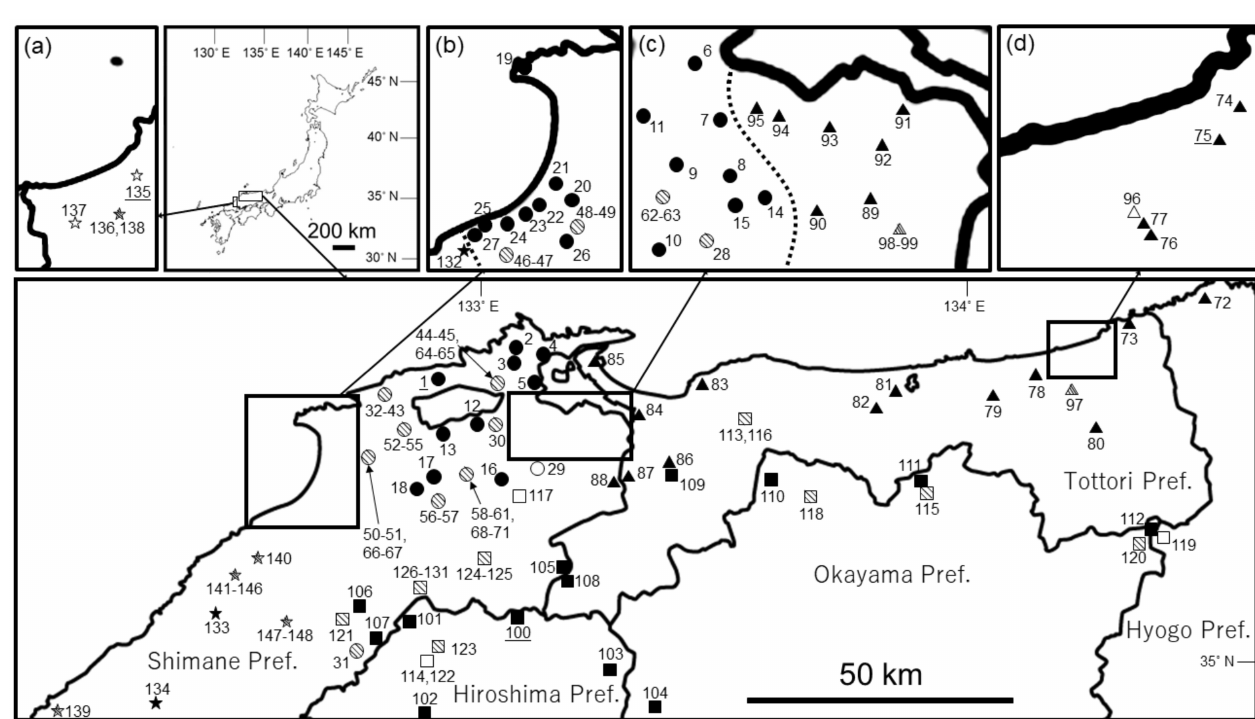
Figure 1. Localities for populations sampled in northern Chugoku, Japan. Population numbers match those used for molecular analyses (see Table S1 and Figure 2). Lower mapped area includes the northern part of Chugoku (Tottori, central to eastern part of Shimane, northern part of Okayama, and northeastern part of Hiroshima Prefectures) and northwestern part of Kinki (Hyogo Prefecture). Top left magnified area ( a ) includes the westernmost part of Shimane Prefecture; ( b ) includes the north central part of Shimane Prefecture; ( c ) includes the easternmost part of Shimane Prefecture; ( d ) includes the eastern part of Tottori Prefecture. The closed symbols correspond to each of four species sampled in this study: H. kunibiki sp. nov. (closed circles), H. setoi (closed triangles), H. utsunomiyaorum (closed squares), and H. iwami (closed stars). The open symbols correspond to each of four species cited from Matsui et al. [3]: H. kunibiki sp. nov. (open circle), H. setoi (open triangle), H. utsunomiyaorum (open squares), and H. iwami (open stars). The open symbols including diagonal lines correspond to each of four species cited from Matsui et al. [3] or Hayashi and Ooi [5] for which the detailed locality is unclear: H. kunibiki sp. nov. (shadow circles), H. setoi (shadow triangles), H. utsunomiyaorum (shadow squares), and H. iwami (shadow stars). For the morphological comparisons, individuals of H. kunibiki sp. nov., H. setoi , and H. utsunomiyaorum were sampled from several localities including all major fragmented distribution areas: H. kunibiki sp. nov. from Pops. 1 (male = 14, female = 6), 2 (male = 2, female = 0), 3 (male = 1, female = 1), 8 (male = 2, female = 0), 17 (male = 2, female = 1), 22 (male = 1, female = 0), and 23 (male = 0, female = 1); H. setoi from Pops. 75 (male = 9, female = 4), 76 (male = 8, female = 2), 81 (male = 5, female = 1), 82 (male = 2, female = 2), 84 (male = 7, female = 5), and 87 (male = 0, female = 1); and H. utsunomiyaorum from Pops. 100 (male = 24, female = 7), 102 (male = 5, female = 1), 111 (male = 4, female = 1), and 112 (male = 5, female = 1). Underlined labels (Pops. 1, 75, 100, and 135) show the type locality of each